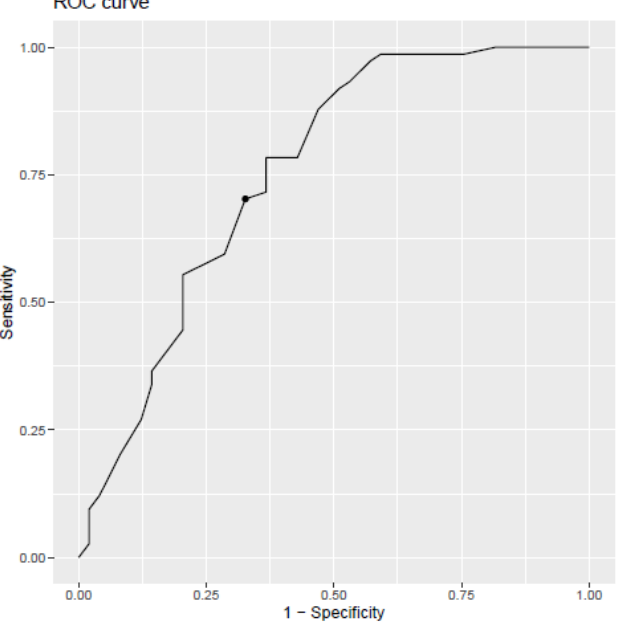
Figure 2. Distribution of cut-off scores for the Oldenburg burnout inventory